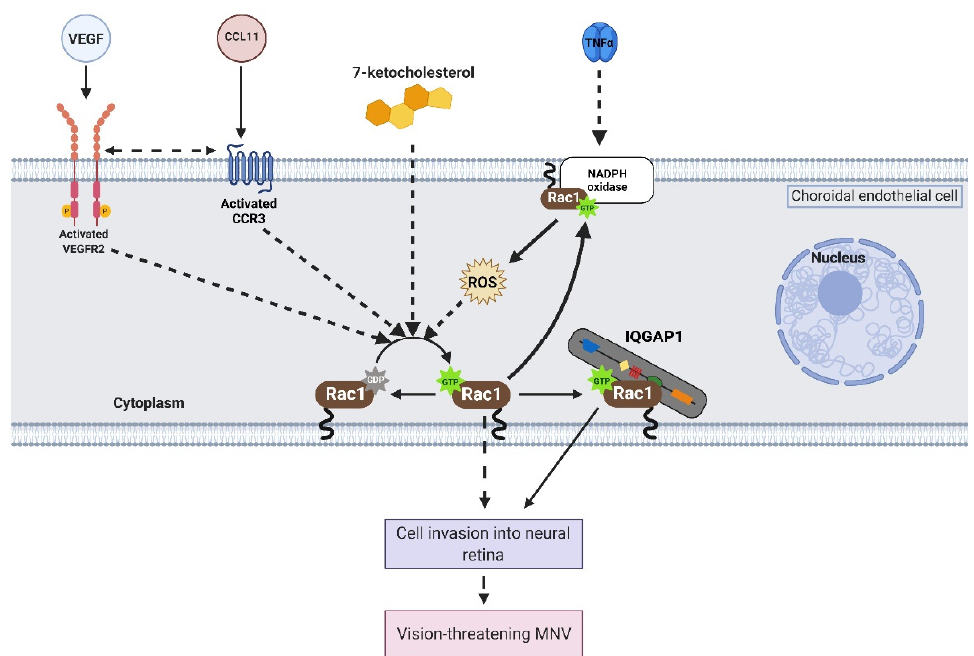
Figure 1. Cross-talk and feed-forward signaling activate Rac1 in choroidal endothelial cells. Vascular endothelial growth factor (VEGF) binds to VEGF receptor 2 (VEGFR2) and activates the receptor tyrosine kinase while C-C motif chemokine 11 (CCL11), an angiogenic eosinophil chemotactic protein, binds and activates signaling through the G protein-coupled receptor, C-C chemokine receptor 3 (CCR3). Each leads to activation of Rac1 (Rac1GTP) and, together, synergistically exacerbate Rac1 activation. Tumor necrosis factor alpha (TNF α ) leads to activation of nicotinamide adenine dinucleotide phosphate (NADPH) oxidase, and the reactive oxygen species (ROS) generated activate Rac1, which can feed-forward to activate NADPH oxidase. 7-ketocholesterol (7KC) increases Rac1 activation. Activated Rac1 binds the GTPase related domain (GRD, dark green oval domain) of IQ motif containing GTPase activating protein 1 (IQGAP1) and has sustained activation. Dashed black lines represent indirect interactions, and solid black lines represent direct interactions (image created with BioRender.com).